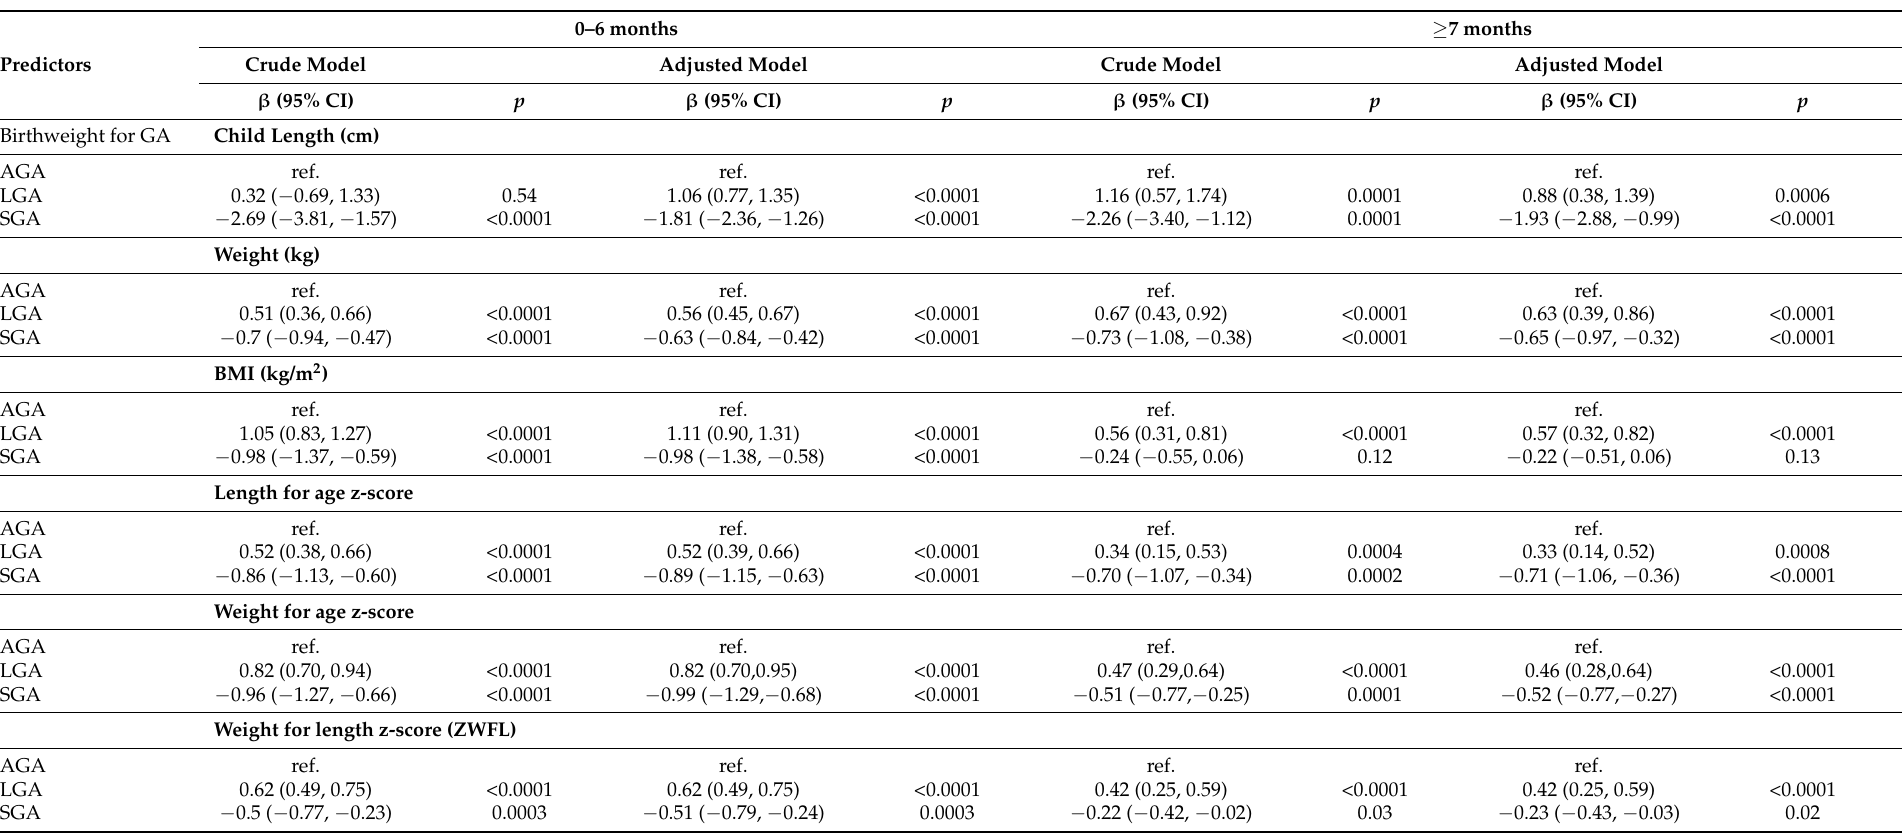
Table 3. Associations between birthweight-for-gestational age status (AGA, LGA, and SGA) and infant length, weight, and weight-for-length z-score from birth to age 25 months in 806